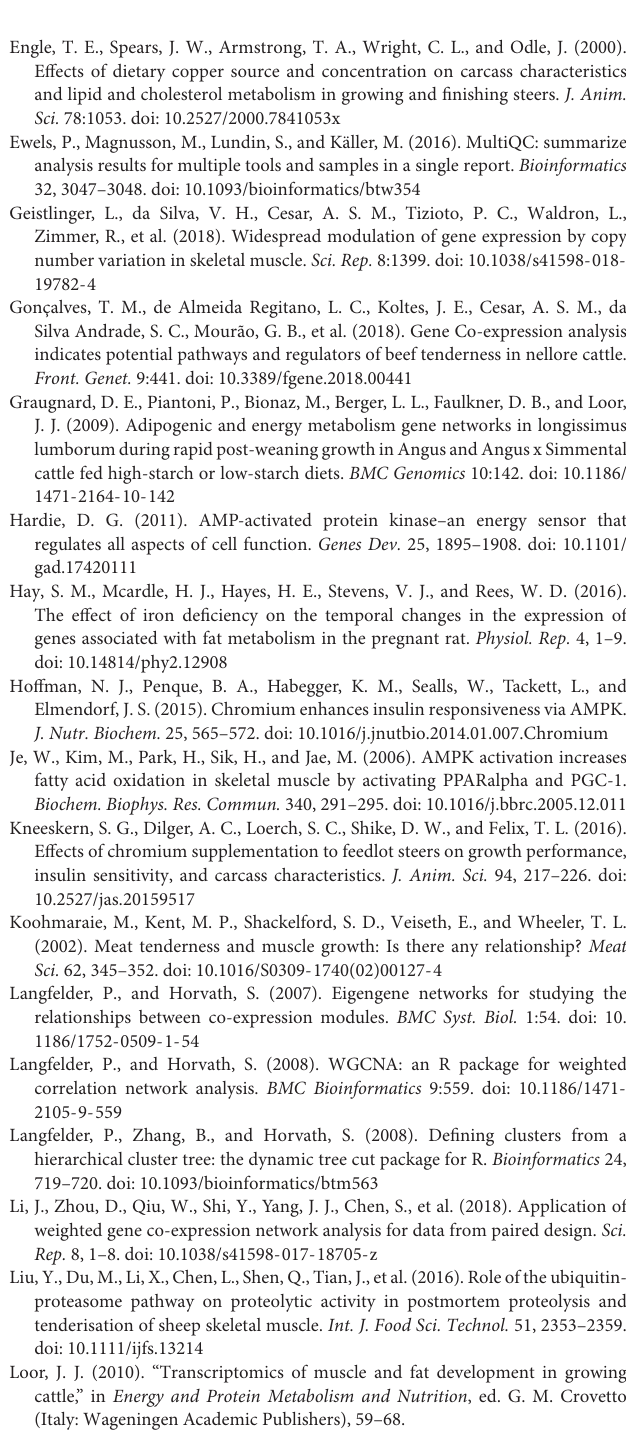
TABLE S6 | Summary of pathway analysis from ClueGo for hub